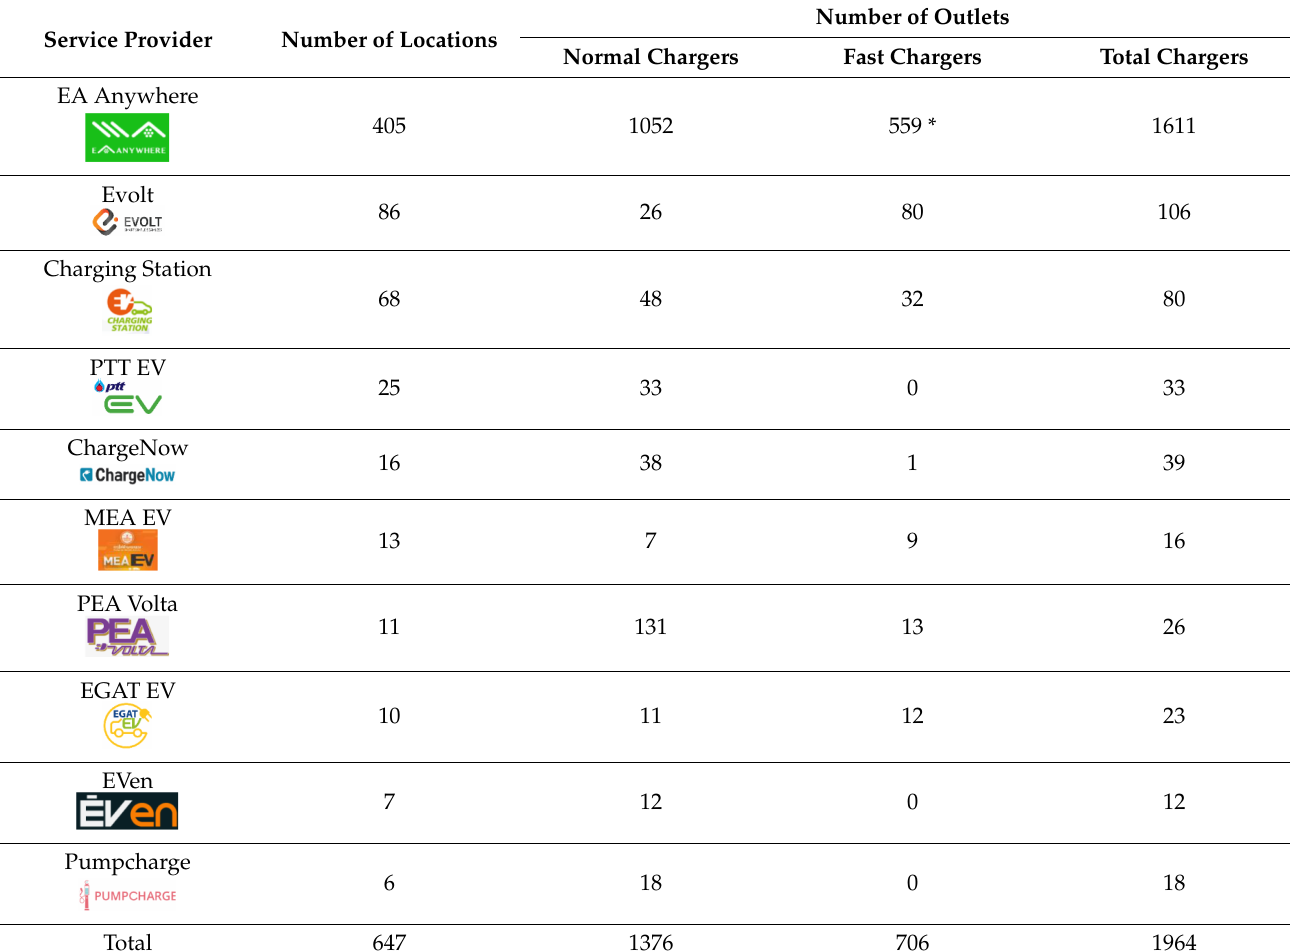
Table 10. Service providers and number of EV charging stations in Thailand in 2020. Number of